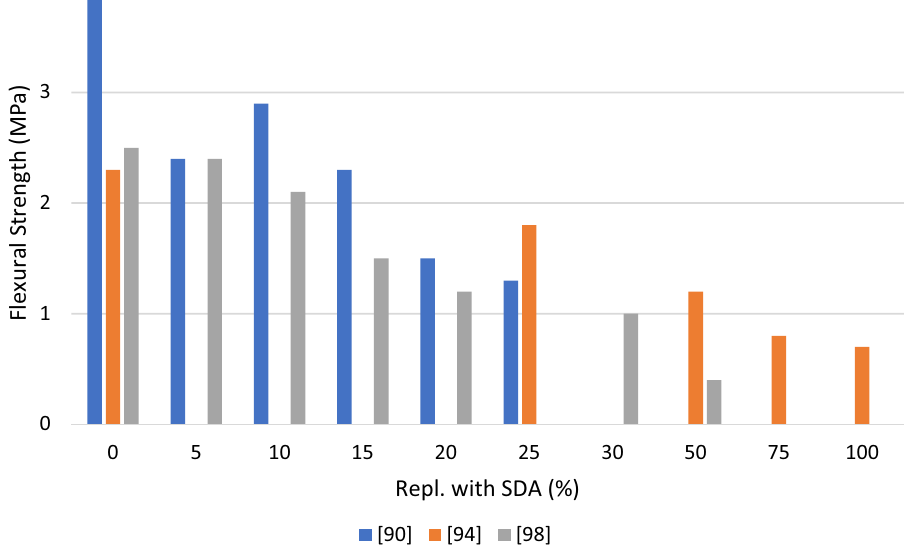
Fig. 6 Test of sawdust concrete by replacing sand with saw- dust [90, 94,